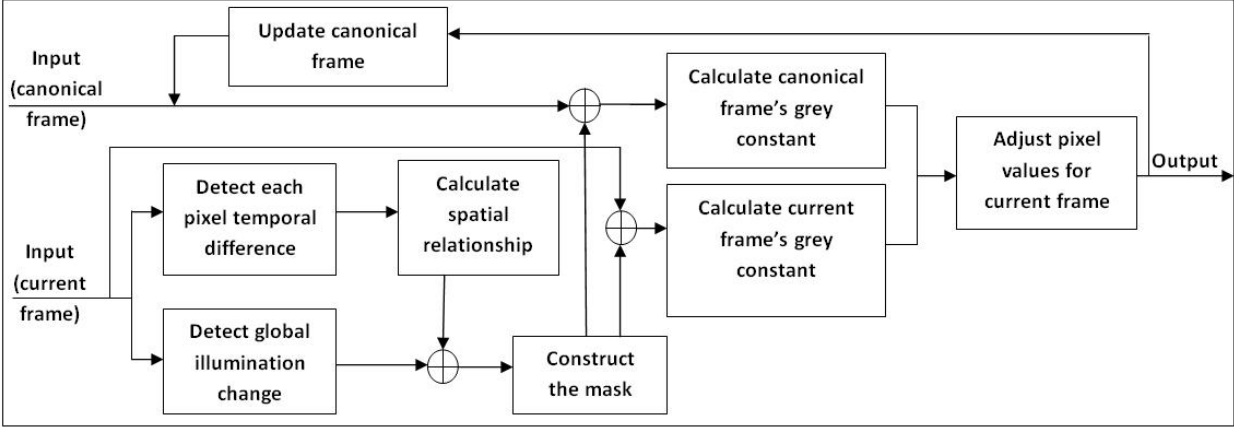
Figure 2. Block diagram of the masked grey world colour constancy